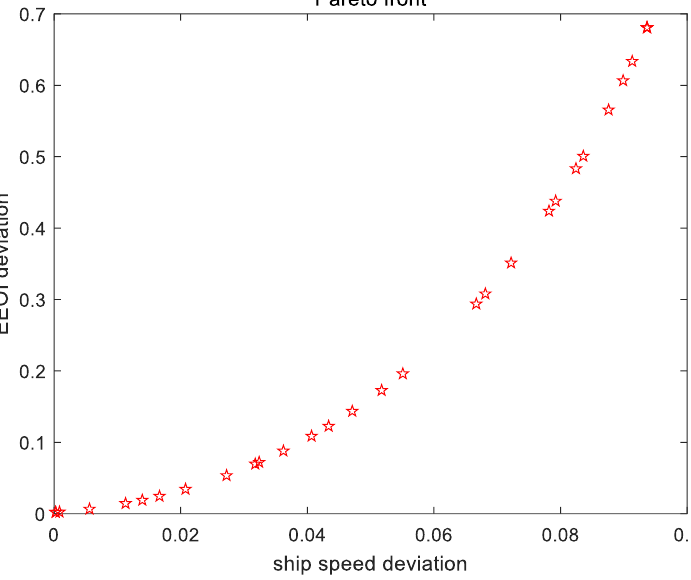
Figure 10. Distribution of non-inferior solutions.